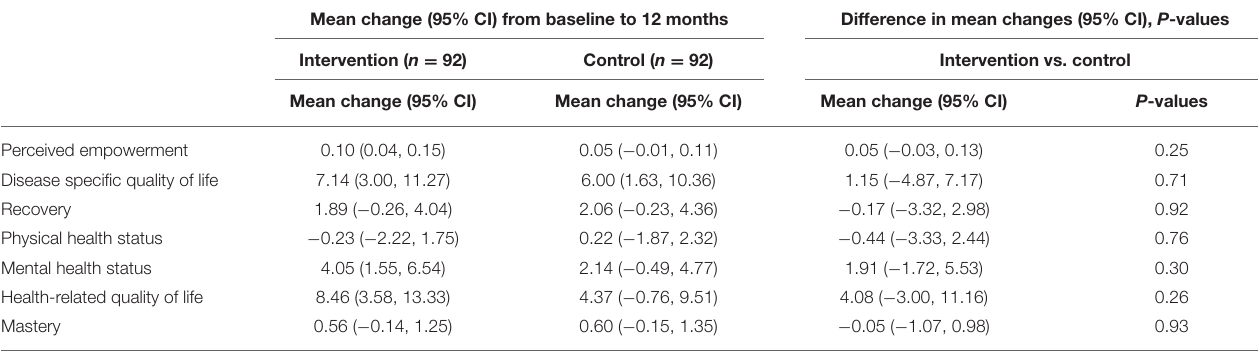
TABLE 3 | Model-estimated mean changes and 95% CIs, and difference in mean changes, 95% CIs and p -values from baseline to 12 months follow up for intervention and control group participants (a priori analysis). Mean change (95% CI) from baseline to 12